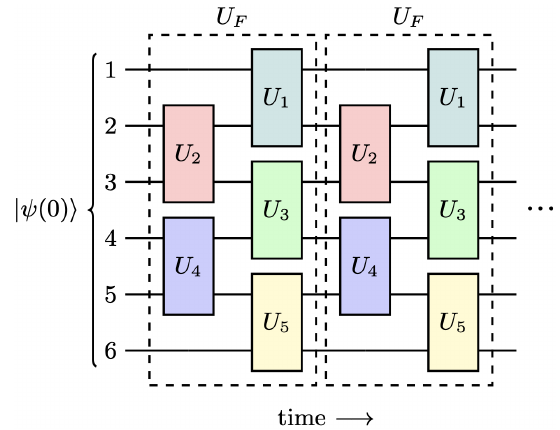
FIG. 2. The time-periodic quantum circuit generating the dynamics of our model system, illustrated on L = 6 qubits. The qubits are numbered top to bottom and time runs left to right. The system is prepared in the state | ψ( 0 ) (cid:5) described later in the main text [Eq. (9)]. Each gate U k takes time T / 2 to be